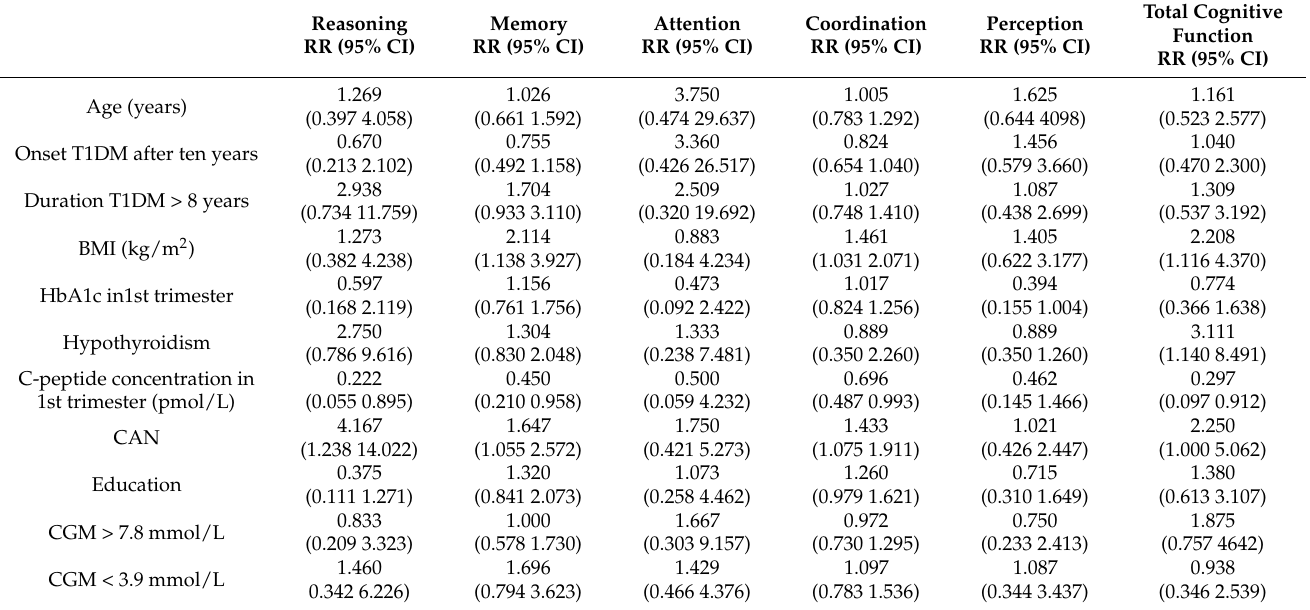
Table 4. The relative risk for cognitive functions in the first